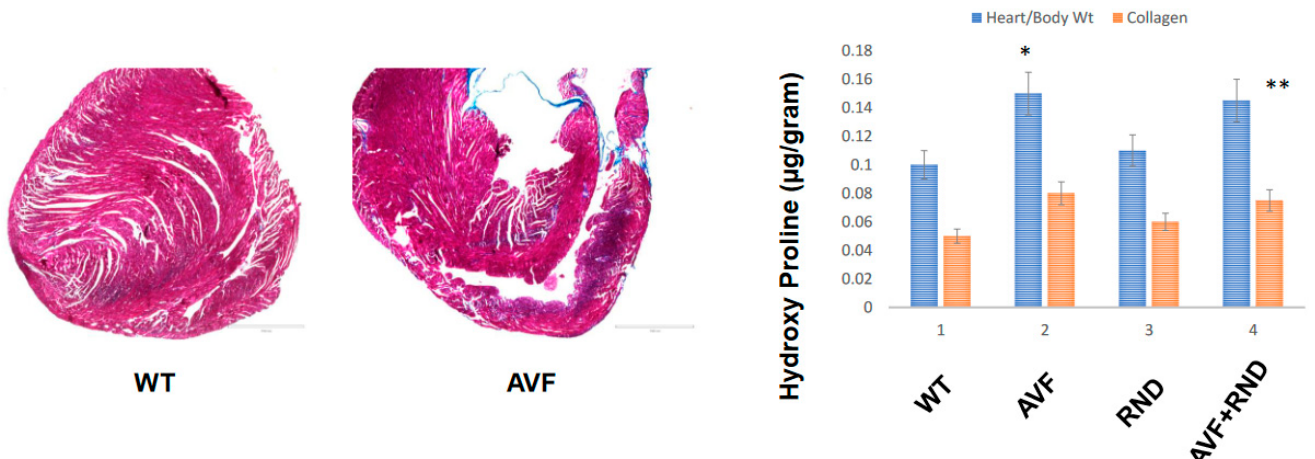
Figure 5. Left panel highlights the collagen trichrome-blue staining for the C57BL/6J WT and AVF male mice at 16 weeks, while the right panel indicates cardiac hypertrophy as estimated by heart weight/body weight ratios and collagen fibrosis via hydroxy proline measurements in C57BL/6J WT-control, AVF, RND, and AVF-RND male mice at 16 weeks. The bar graph represents hypertrophy in ratio (g/g) and hydroxyproline (µg/g of the tissue). The mean ± SD from n = 5; *, p < 0.05 compared to WT; **, p < 0.05 compared with AVF, the scale bar in the left panel = 1000 µM.